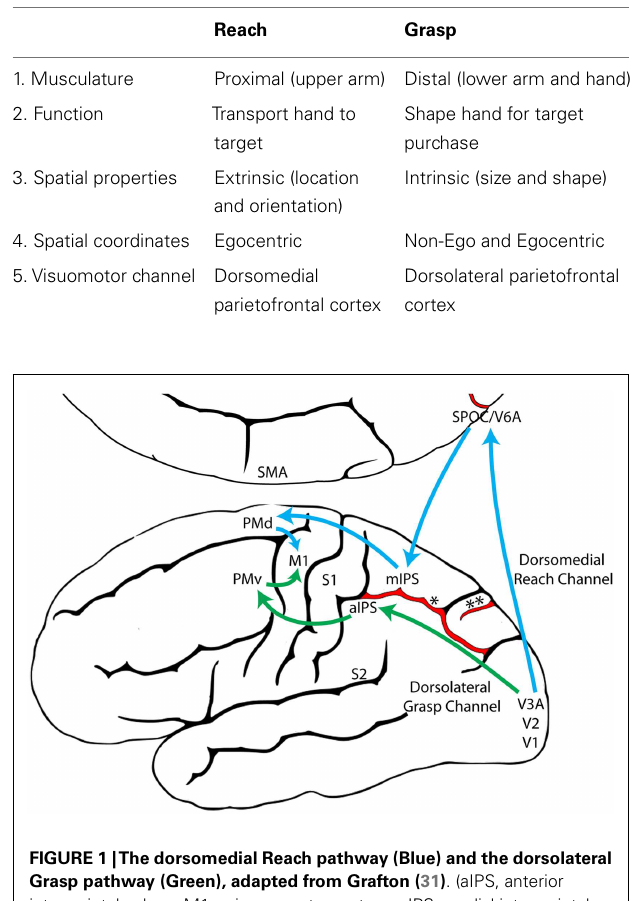
Table 1 | Reach and Grasp components of the DVC theory .